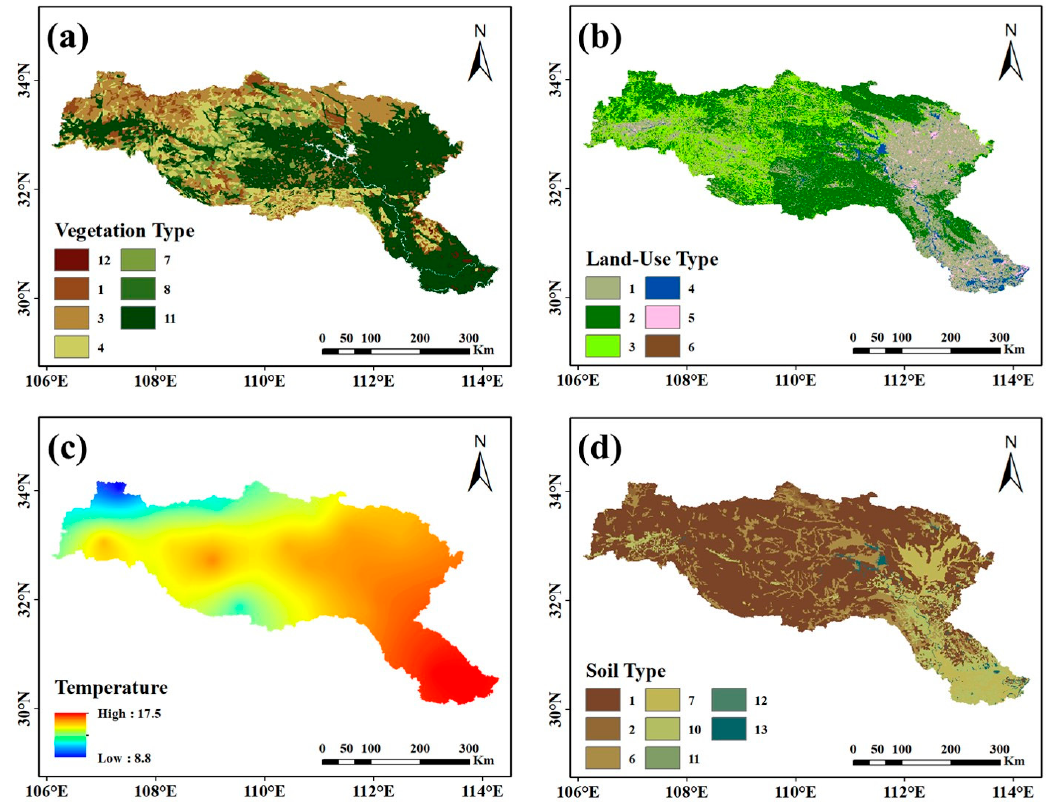
Figure 6. Distribution of the main influencing factors of NDVI: ( a ) vegetation type, ( b ) land-use type, ( c ) temperature, ( d ) soil type.